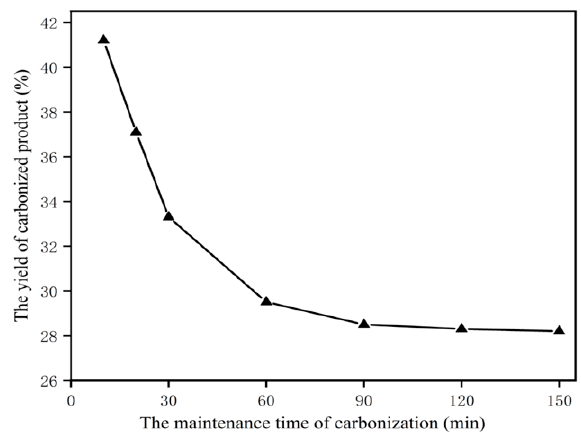
Figure 9. The curve for the yield of carbonized product with different carbonization maintenance times.